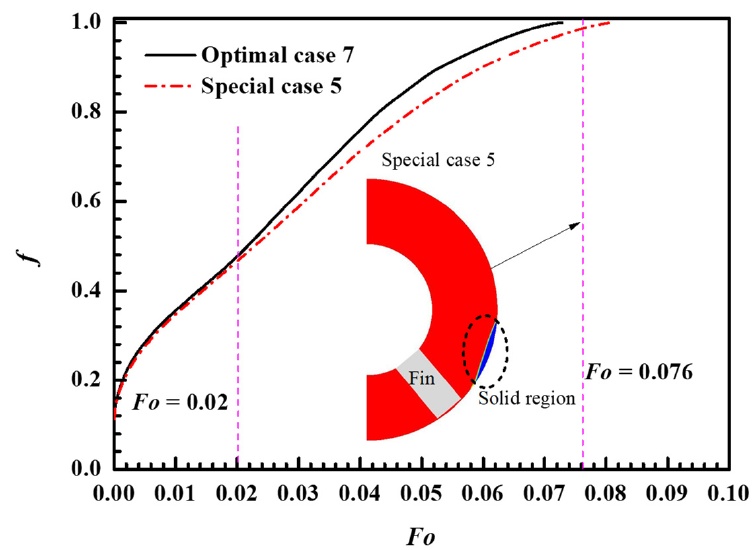
Figure 13. Contour maps of liquid fraction and dimensionless temperature for Optimal Cases 6 and 7 and Special Case 5.